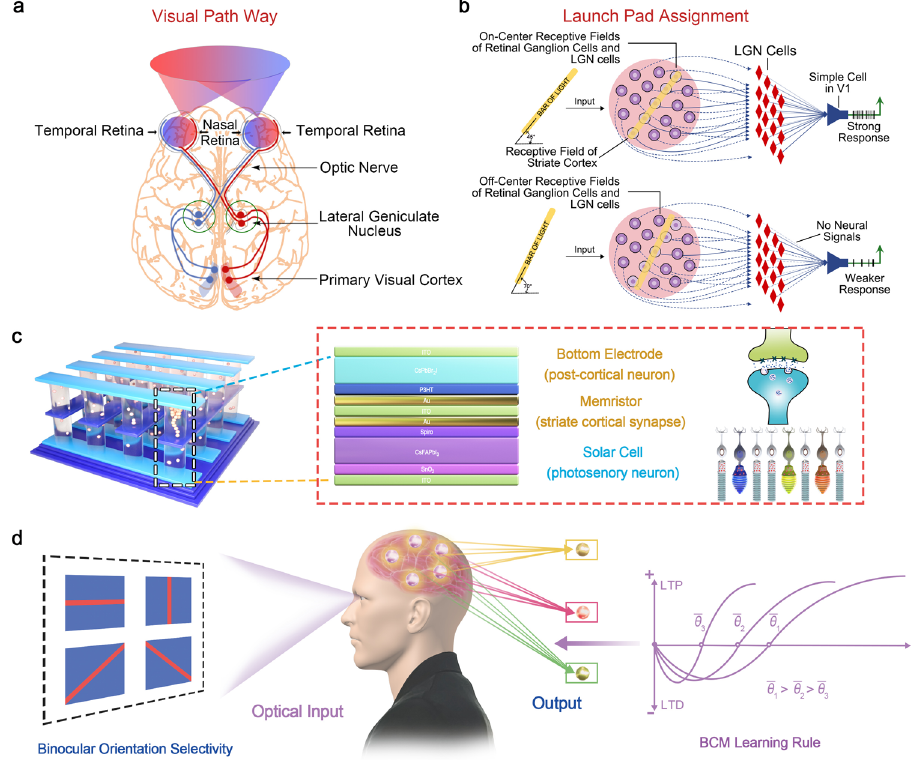
Fig.1|Arti fi cialstriatecortexbasedonself-poweredmemristor.a Thehierarchy of human visual system for light perception and processing. b The convergence process of receptive fi eld in different level of visual system. c The concept of